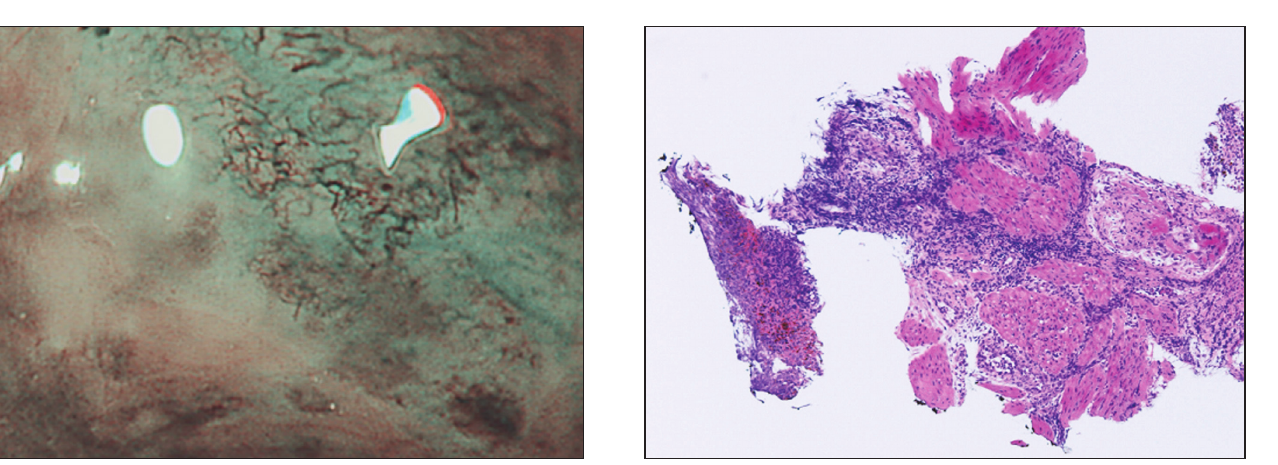
Figure 5) Biopsy of black stripes revealed leukocytic infiltration with hemo- siderosis. Neither multinucleated giant cells, viral inclusion bodies nor fun- gus were observed. Hematoxylin eosin stain, original magnification ×4